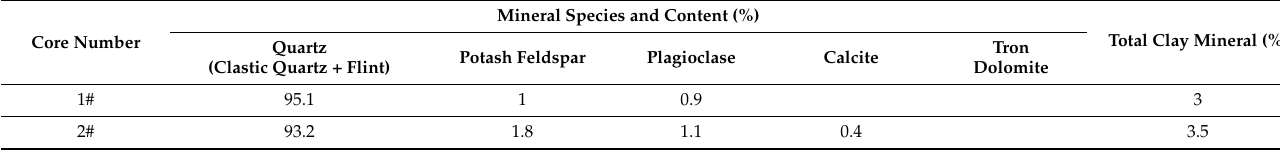
Table 2. Types and contents of mineral in oil sand samples.